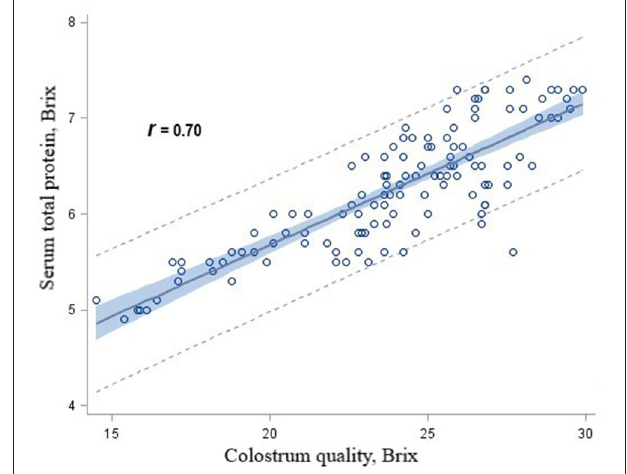
quality overlaid with the fit line, a 95% confidence band and lower and upper 95% prediction limited for heifer calves born to Holstein dairy cows fed ruminally protected lysine or methionine or the two in combination during the close-up pre-calving